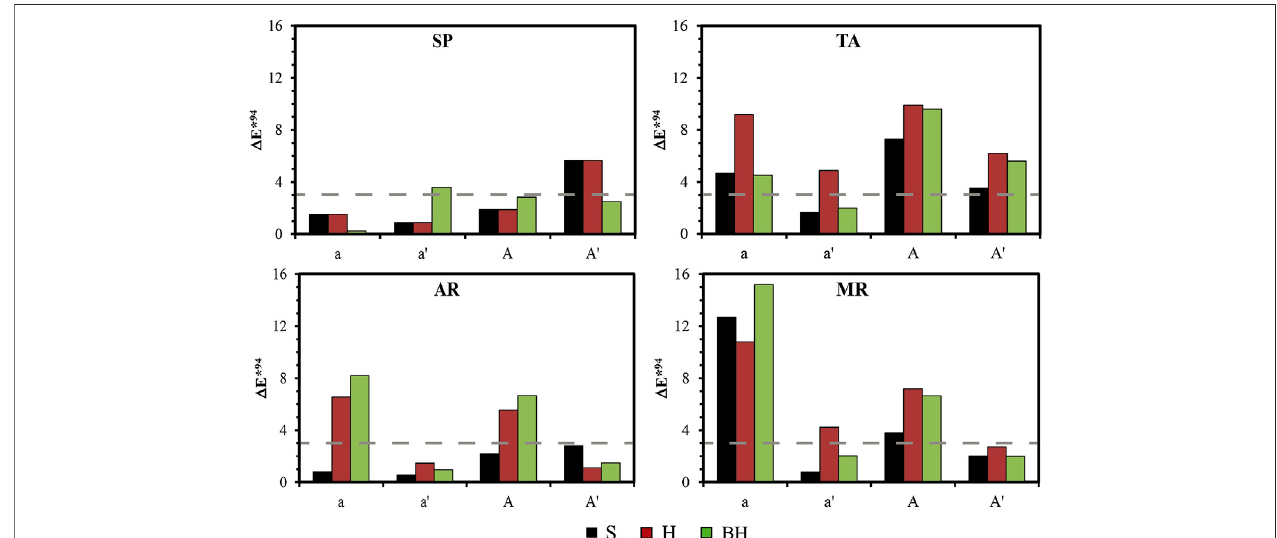
FIGURE 7 | Measurements of the color difference ( Δ E*) for each surface fi nish (S: saw-cut, H: honed and BH: bush-hammered) of the four varieties of rock from SolutionAwithoutHAP(aanda ′ )andwithHAP(AandA ′ ).Legend:CalcarenitadeSantaPudia(SP);TravertinoAmarillo(TA);AreniscaRonda(AR);MolinazaRoja(MR);a and a ′ , Difference between the altered samples before and after removal of the gypsum crust compared to the fresh and untreated samples, respectively; A and A ′ , Difference between the samples before and after removal of the gypsum crust compared to the fresh and treated samples (A and A ′ , respectively). The broken line marks the limit for appreciable color difference Δ E* (cid:1)